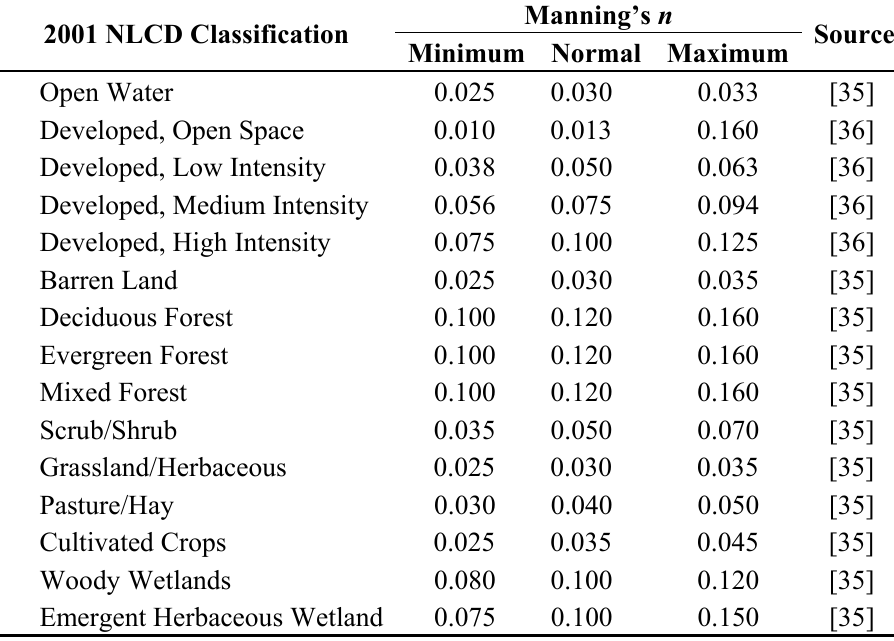
Table 2. Manning’s n values for 2001 National Land Cover Database (NLCD)